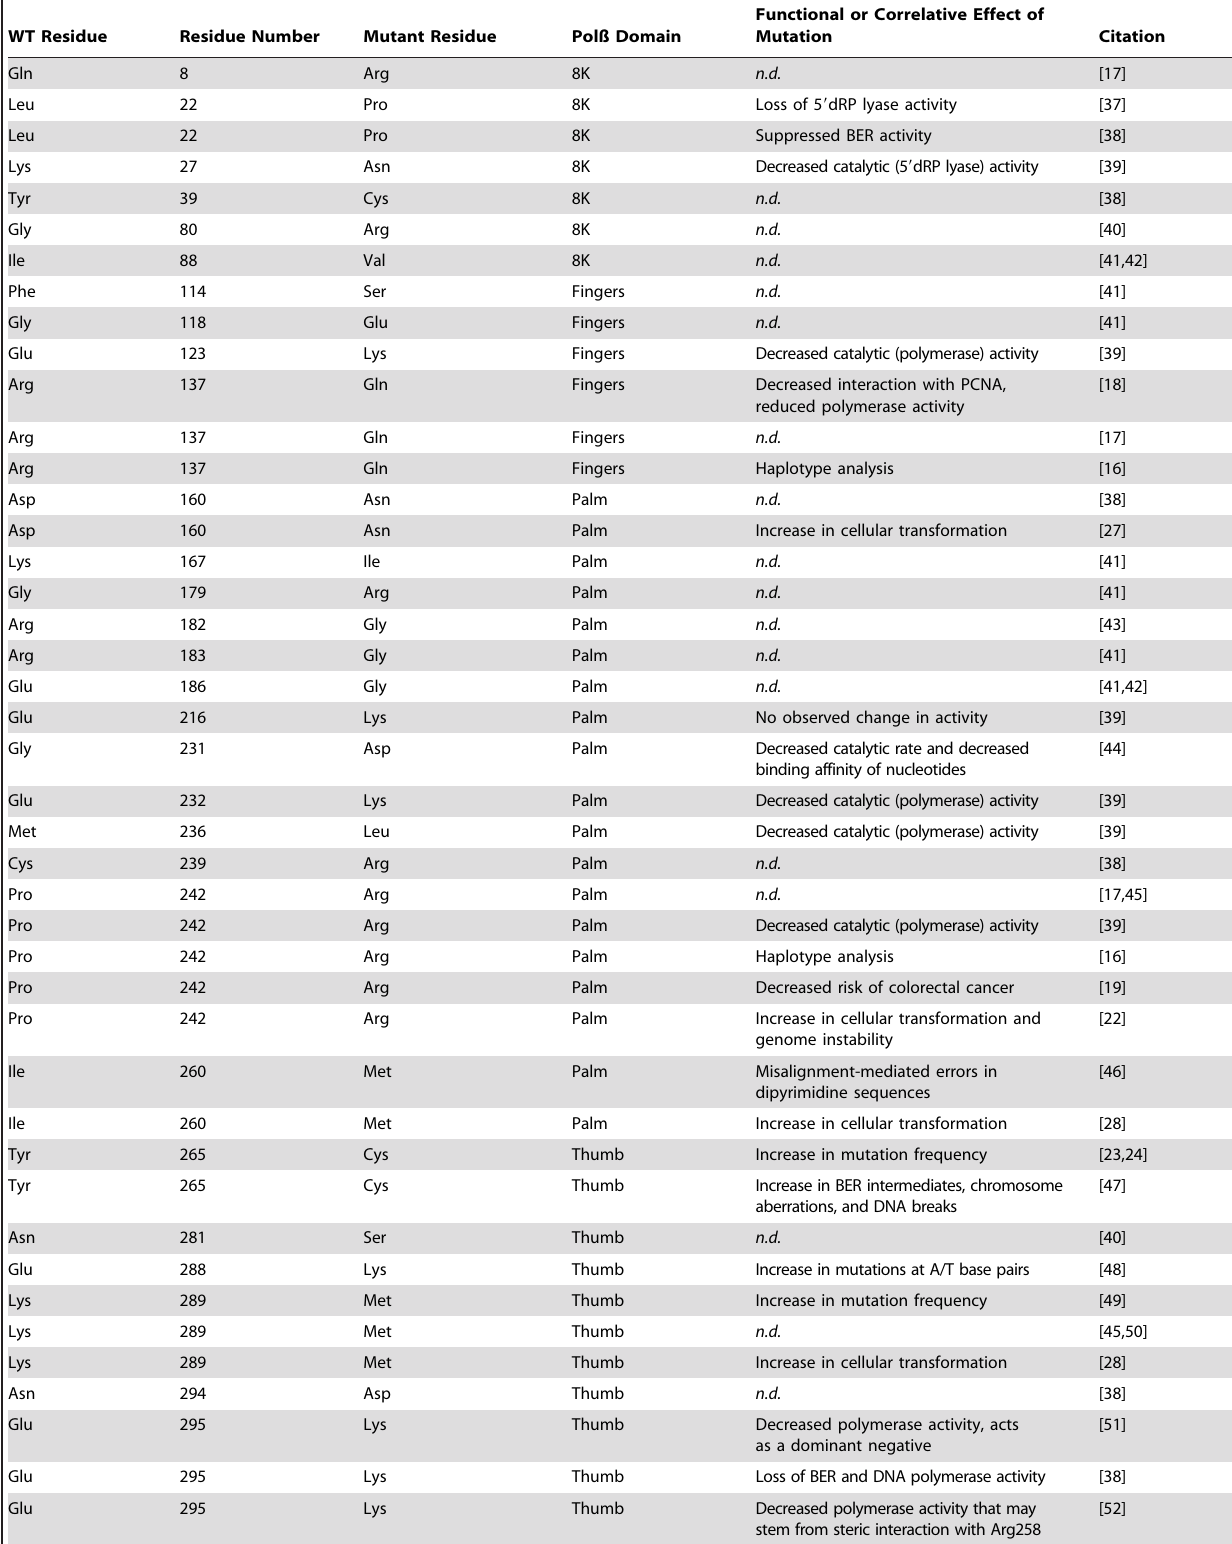
Table 1. Germline and somatic POLB